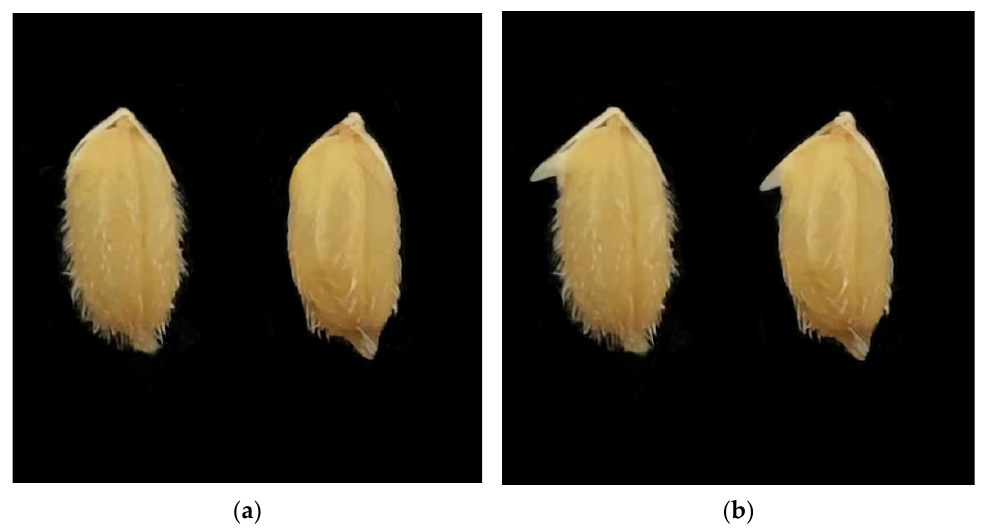
Figure 1. Criteria of seed germination. ( a , b ) Photographs of rice seeds showing the definition of germination ( a ) and no germination ( b ).